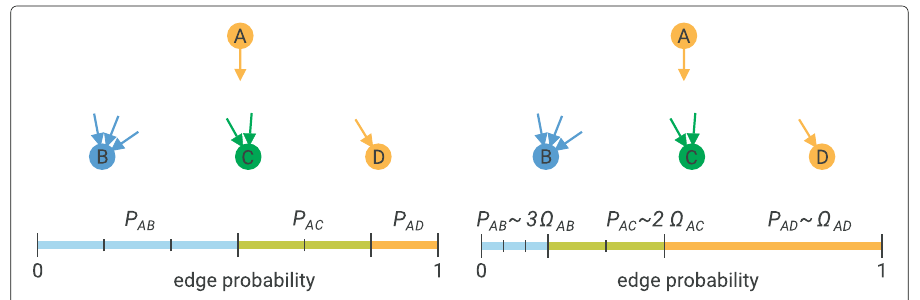
Fig. 1 Probabilities of connecting different stubs. Graphical illustration of the probability of connecting two vertices as a function of degrees (left figure), and degree and propensities (right